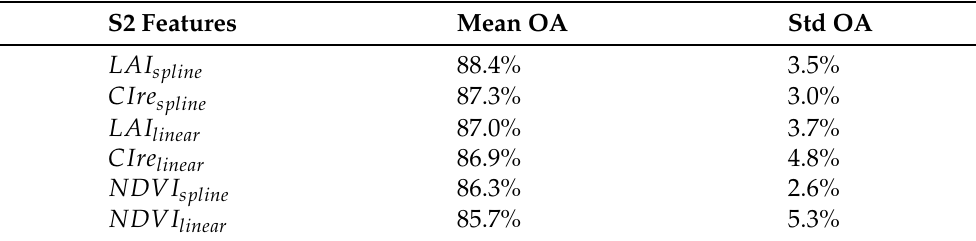
Table 2. Classification algorithm calibration results with the Sentinel-2 features. For each feature time series, the mean overall accuracy (mean OA) and its standard deviation (std OA) over the 4 iterations of the cross-validation scheme are given.